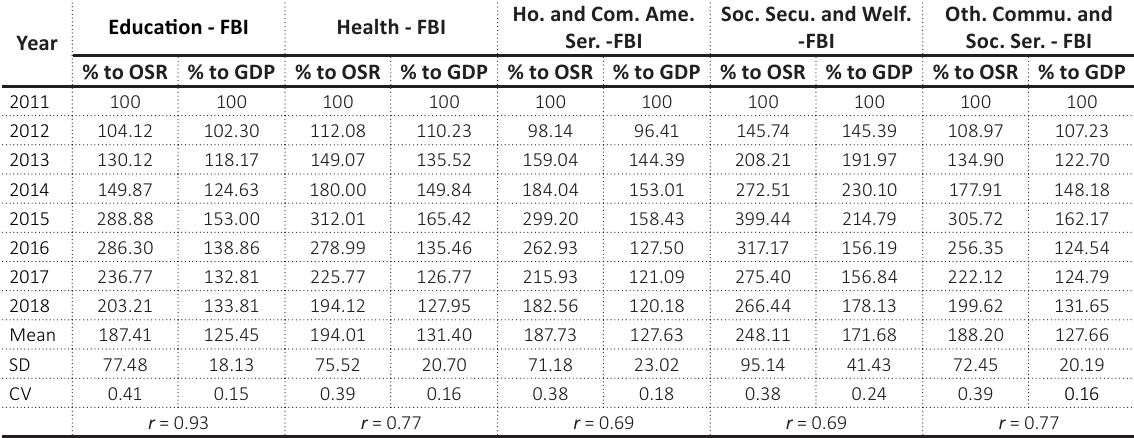
Table 7. Summary of comparison of CBI and FBI between OSR and GDP of Saudi Arabia r between % of pub.